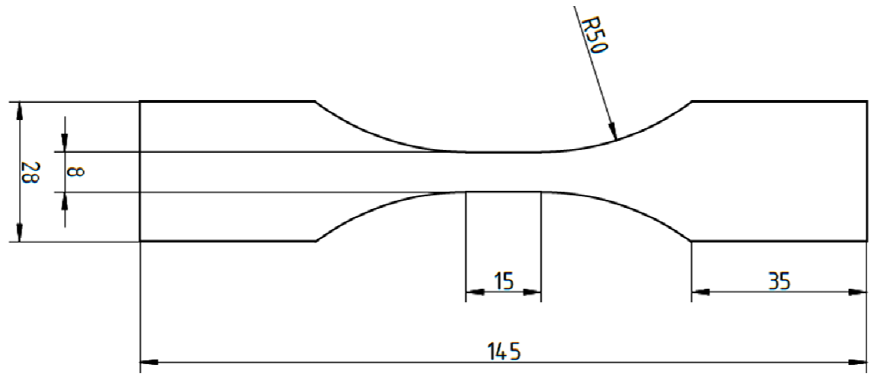
Figure 2. Geometry of the fatigue specimen, sizes in mm.